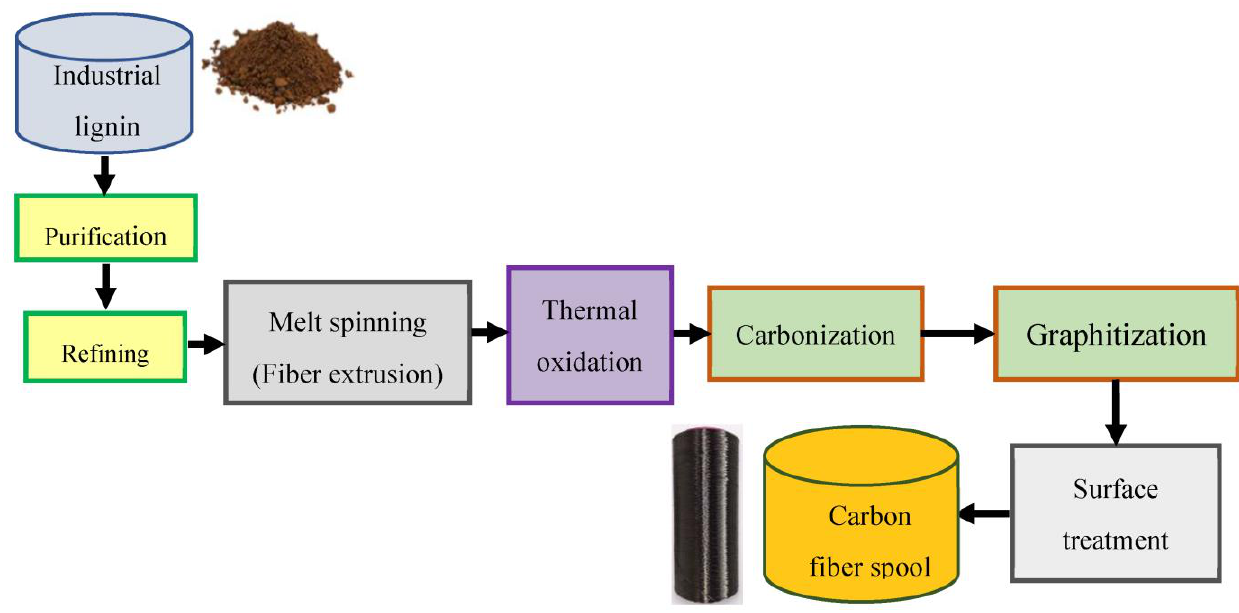
Figure 4. Process of fiber production from industrial lignin.